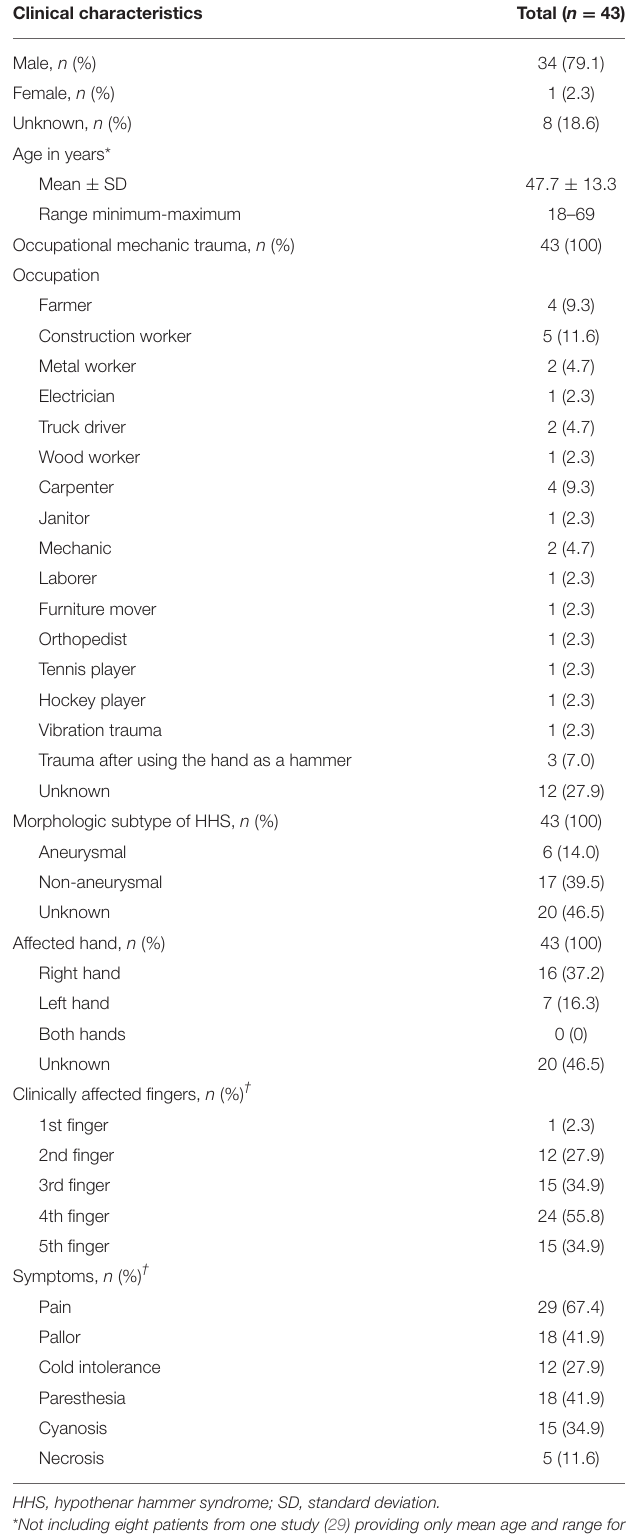
TABLE 2 | Patients’ clinical characteristics before intra-arterial